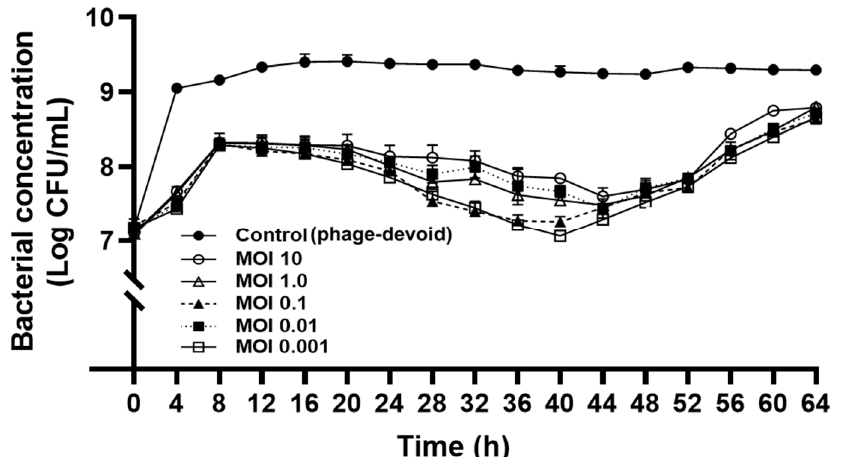
Figure 4. Bactericidal effect of KFS-EC3. An overnight culture of E . coli O157:H7 ATCC 10536 was infected with various concentrations of KFS-EC3 at a MOI of 10 (open circle), 1.0 (open triangle), 0.1 (closed triangle), 0.01 (closed square), and 0.001 (open square), respectively.